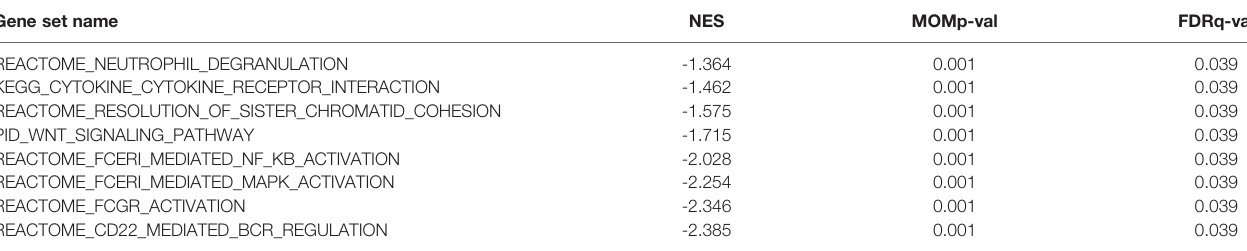
TABLE 3 | Gene sets enriched in